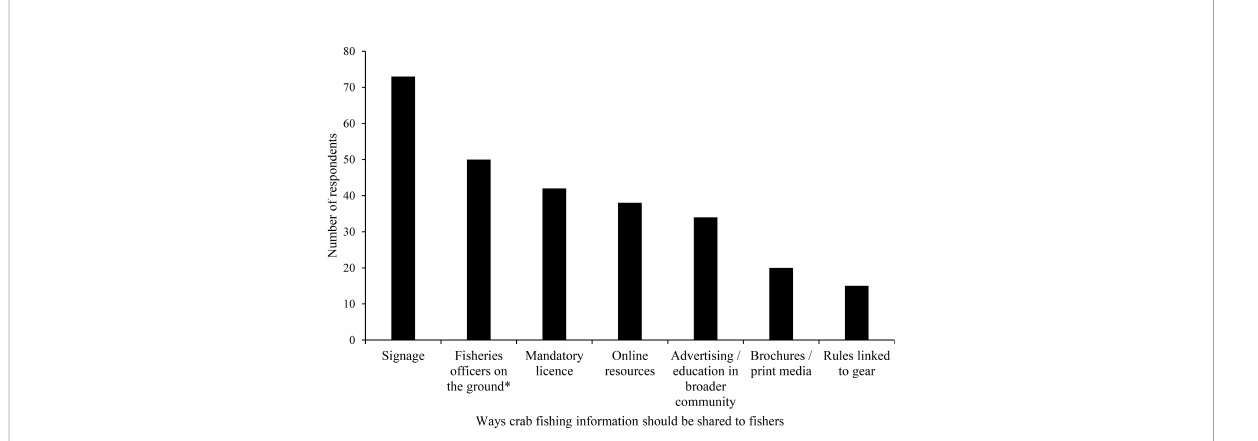
FIGURE 2 Ways in which information about crab fi shing should be shared with fi shers according to Peel-Harvey blue swimmer crab fi shers. Note: *Fisheries of fi cers on the ground includes comments relating to fi sheries volunteers performing information-sharing duties. Themes derived from free-text